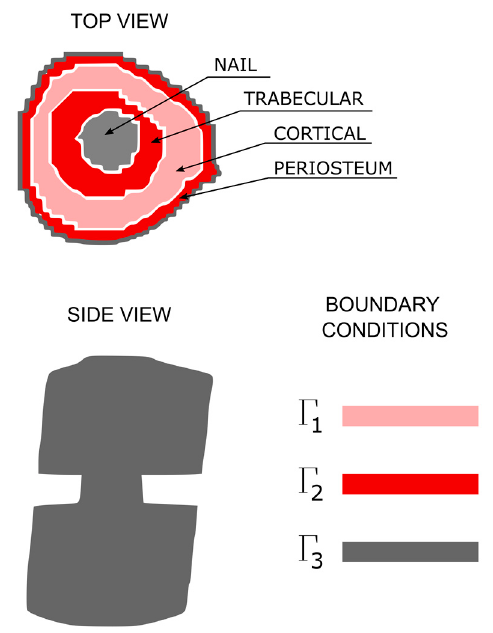
Figure 3. Boundary conditions in the 3D model representing a diaphyseal section of the femur with a transverse fracture.